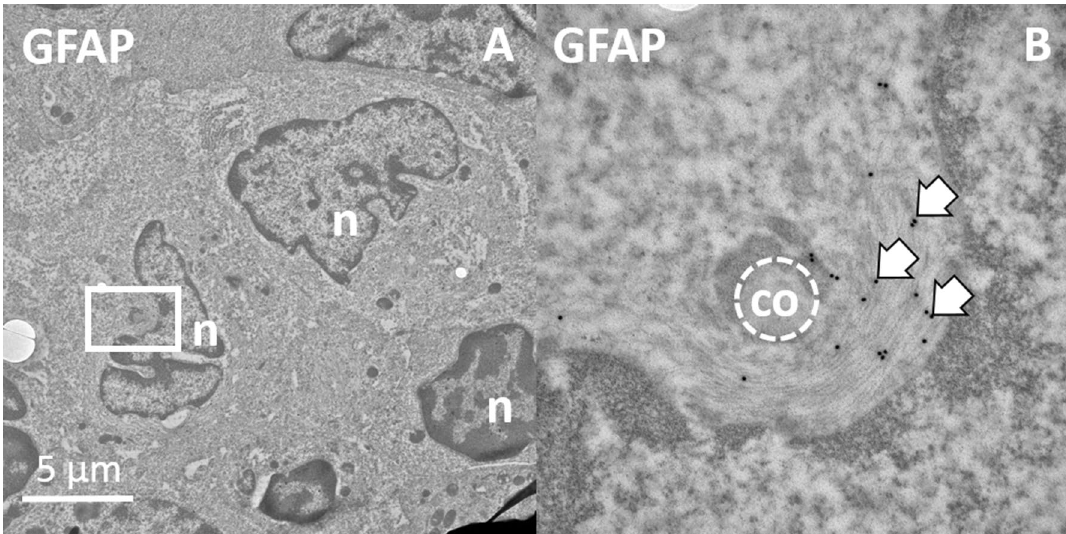
Figure 6. Ultrastructural image of a cell taken with a transmission emission microscope. ( A ) The picture shows several nuclei (n) with corresponding cytoplasm. ( B ) The central stromal cell (FRC) cell secretes collagen into a conduit system (co). Filamentous structures in the cytoplasm around this conduit are immune positive for GFAP (arrows) labeled using the polyclonal